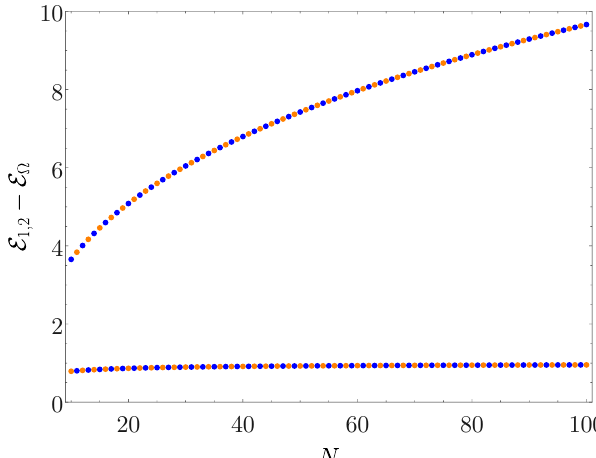
Figure 44. The first two energies E 1 and E 2 (after subtracting the Casimir energy E Ω ) of the Hamiltonian H ( g ) for g = − 1 / 2 , scanning over a range of cutoffs N . Blue (resp. orange) points N label Z even (odd) states. In particular, it is clear that E 2